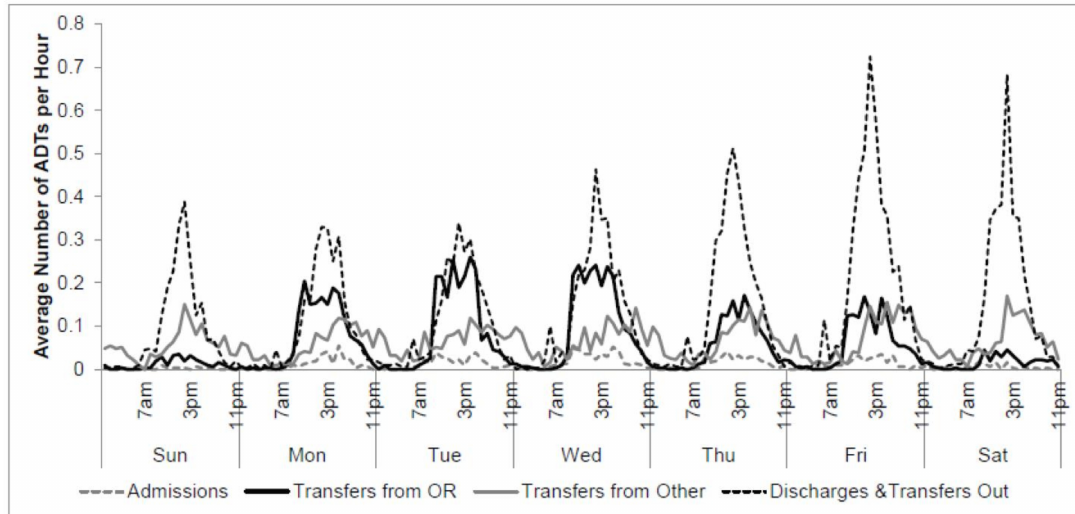
Figure 8. Weekly activity: admissions, transfers in, transfers out, and